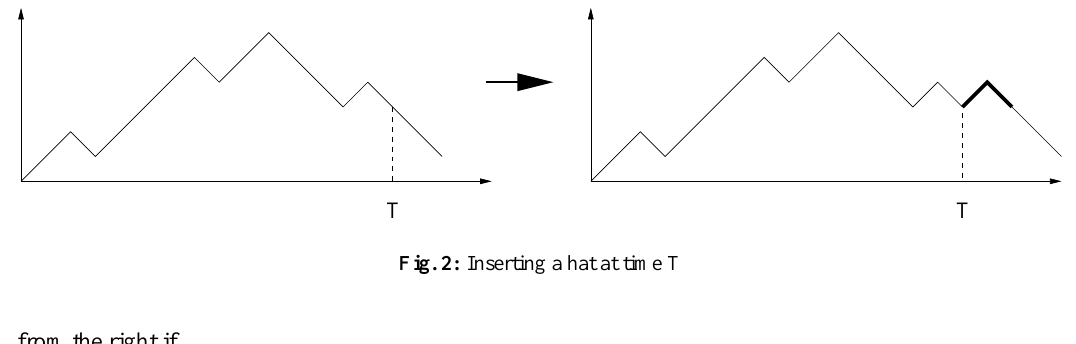
Fig. 2: Inserting a hat at time